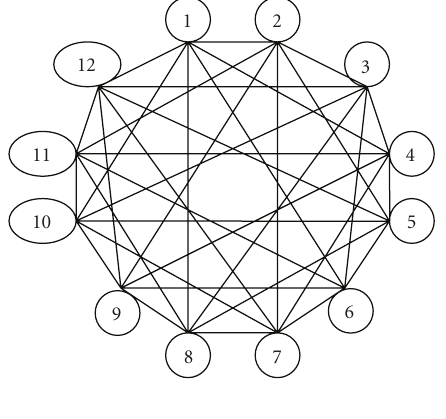
Figure 4: A (6,4) cage graph.